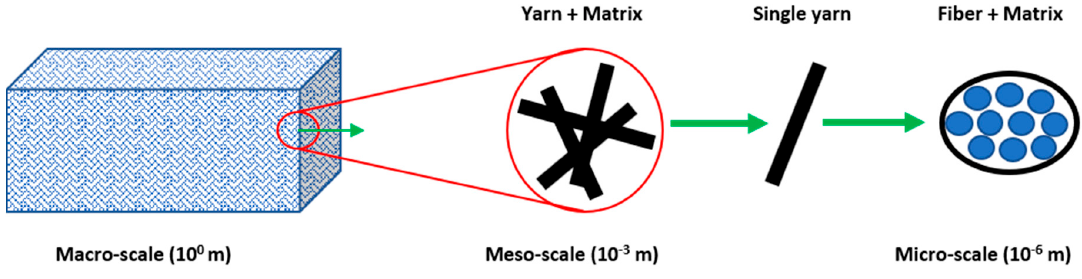
Figure 1. Multi-scale modeling (macro, meso, and micro-scale).